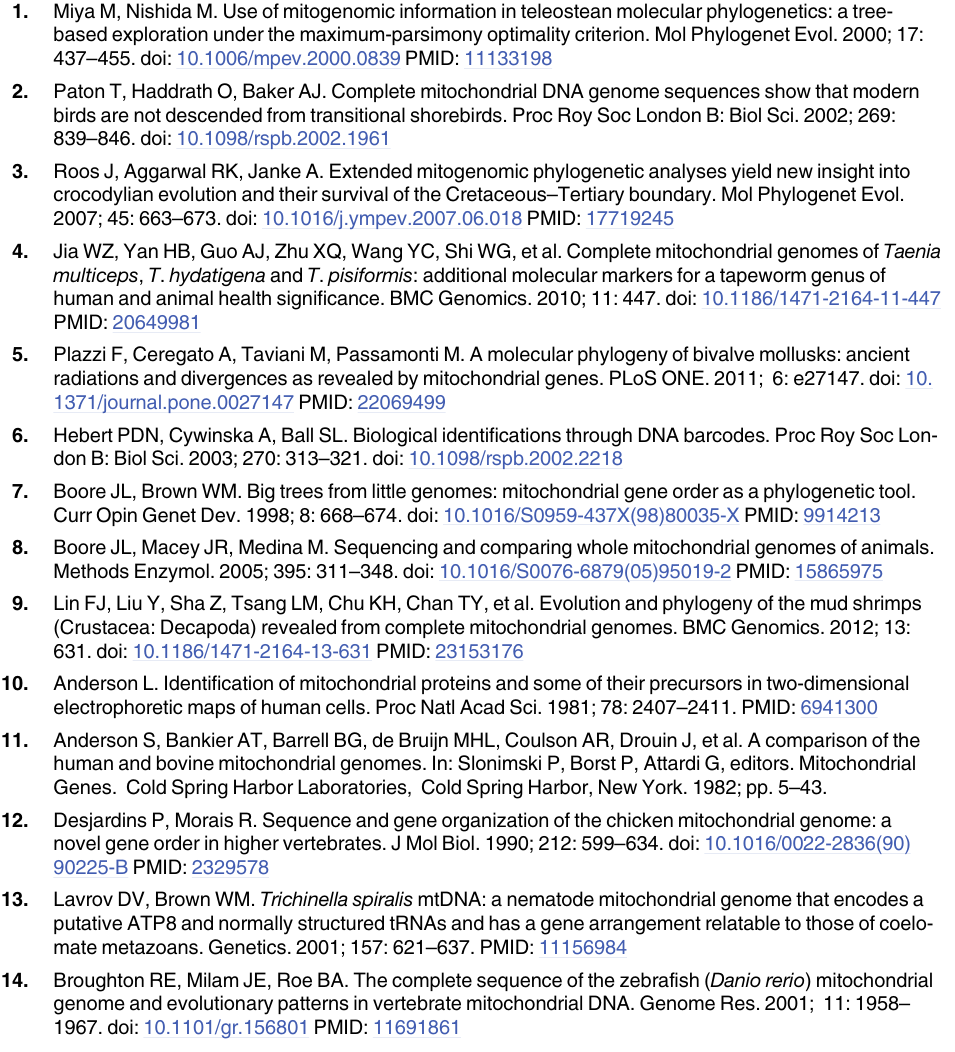
S3 Table. Start and stop codons for all 13 protein-coding genes from the mitochondrial genomes of